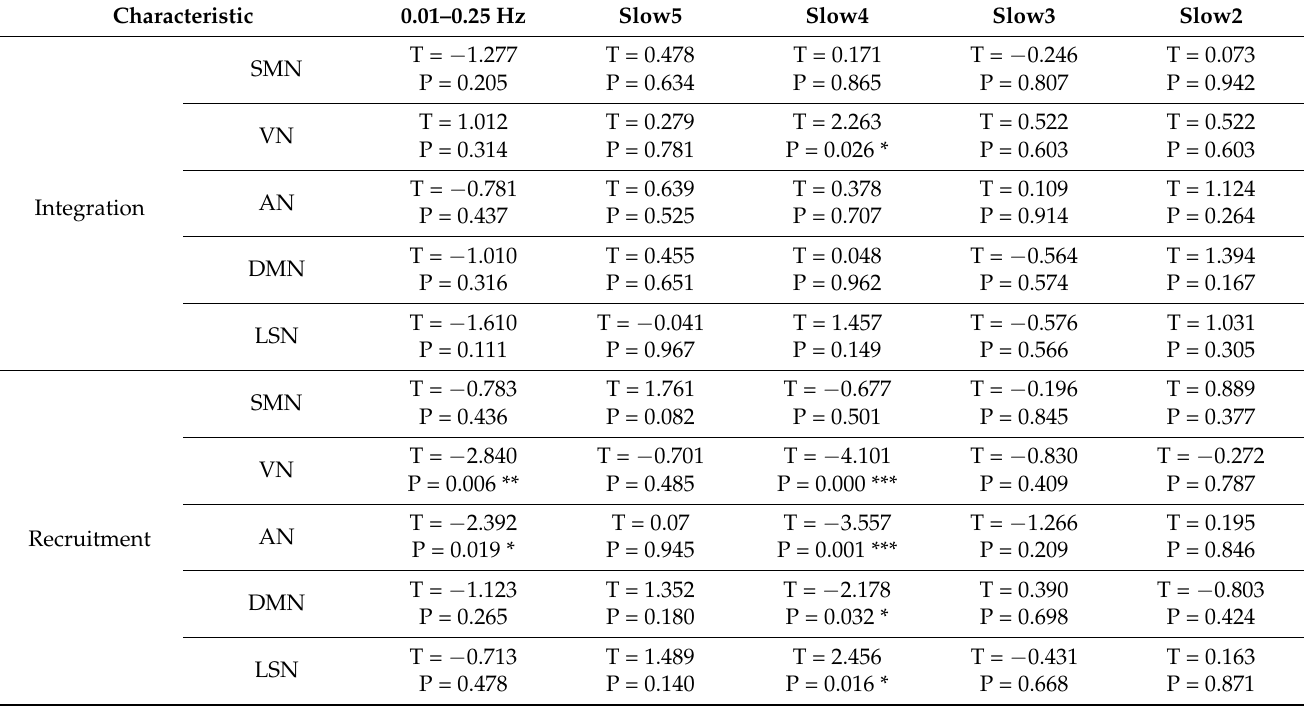
Figure 3. The difference of integration and recruitment from full frequency (0.01–0.25 Hz), slow5 (0.01–0.027 Hz), slow4 (0.027–0.073 Hz), slow3 (0.073–0.198 Hz), and slow2 (0.198–0.25 Hz) in the RSN level between NC and SZ. ( A ) Integration. ( B ) Recruitment. Asterisk indicates pairwise group differences; *** represents p < 0.001, ** represents p < 0.01, * represents p < 0.05. Table 3. Integration and Recruitment of brain networks in full frequency (0.01–0.25 Hz), slow5